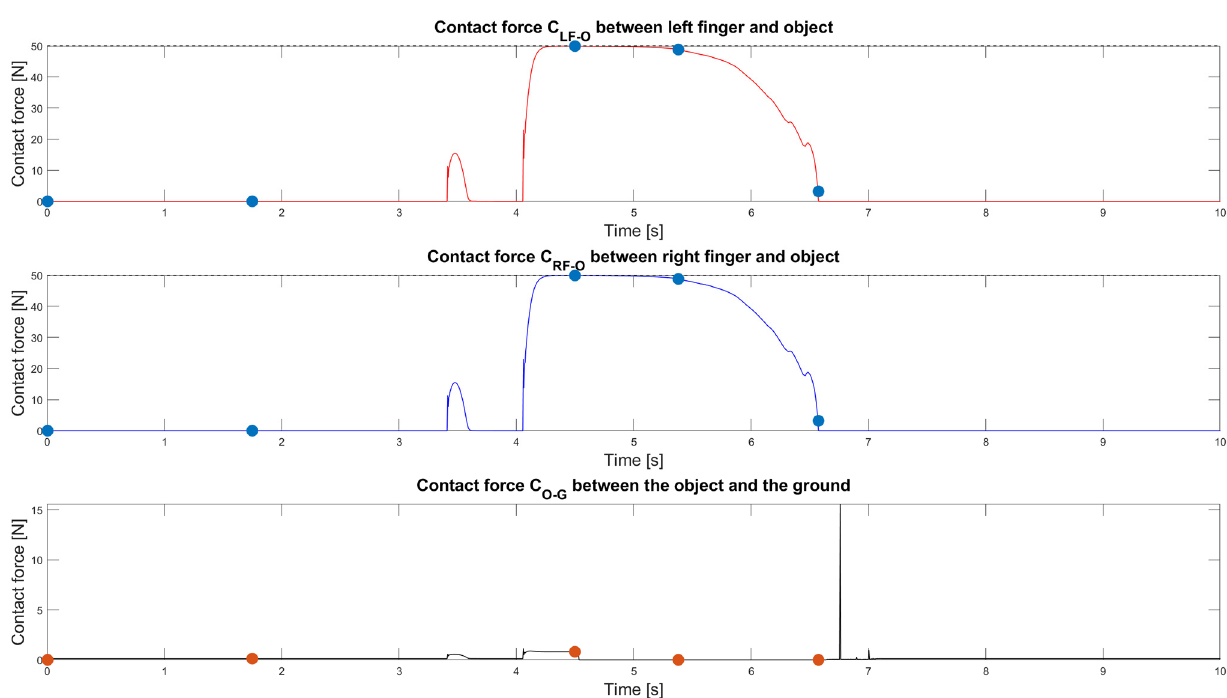
Figure 18. Graphical analysis of the third pick-point. Source: own.